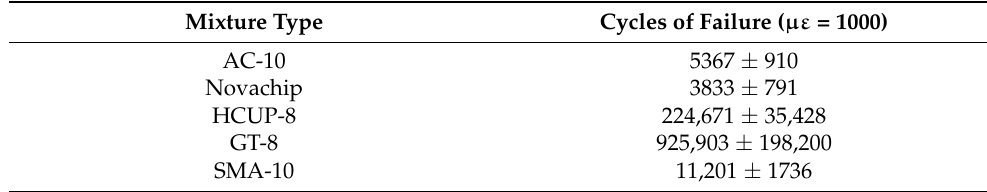
Table 14. Results of four point bending fatigue test.